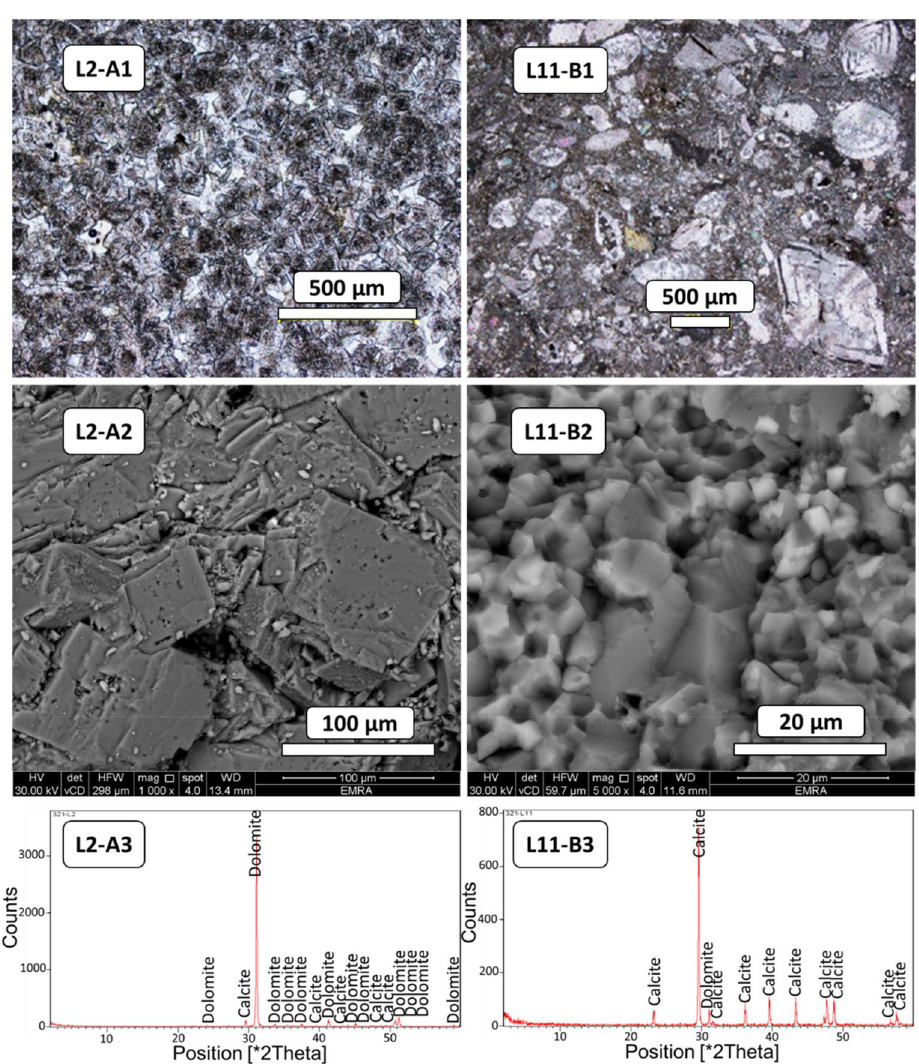
Figure 4. (L2–A1) Images of cross-polarized light showing relatively large dolomite crystals, (L2–A2) and (L2– A3) showing texture and mineralogy of limestone: calcite matrix and cement enlarged using SEM in (L2–A2), minerals identified using XRD in (L2–A3). (L11–B1) Images of cross-polarized light showing relatively large fossils embedded in a dominantly calcite matrix (L11–B2) and (L11–B3) showing texture and mineralogy of limestone: calcite matrix enlarged using SEM in (L11–B2) and minerals identified using XRD in (L11–B3).